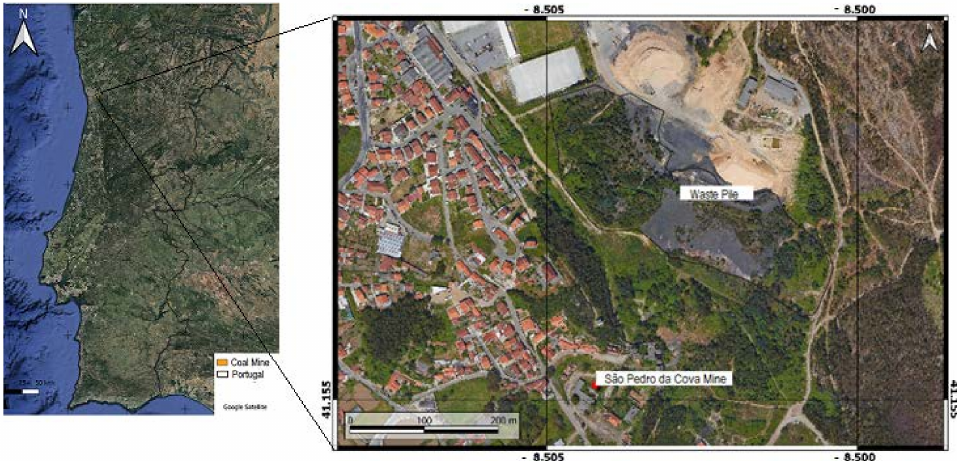
Figure 2. Study area (adapted from